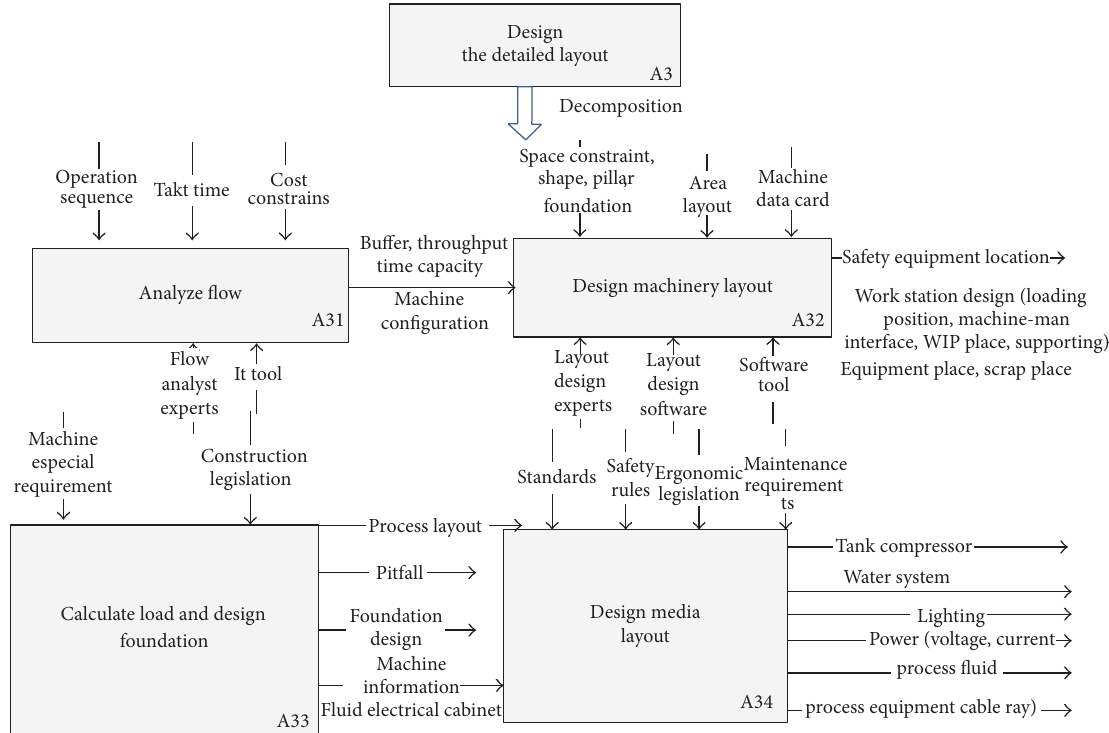
Figure 8: Factory layout activity modelling using IDEF0 (breakdown structure of the activity “Design the detailed layout”).